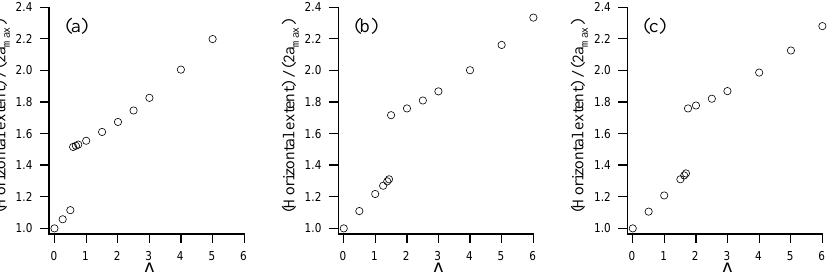
FIG. 7. The horizontal extent of the particle initially located at the inner edge of the core in lower density cases. Three different beam densities are considered, i.e., (a) h x (cid:1) 0.98 , (b) h x (cid:1) 0.95 , and (c) h x (cid:1) 0.92 . Other parameters are fixed to M (cid:1) 0.13 and j (cid:1) 0.15 .